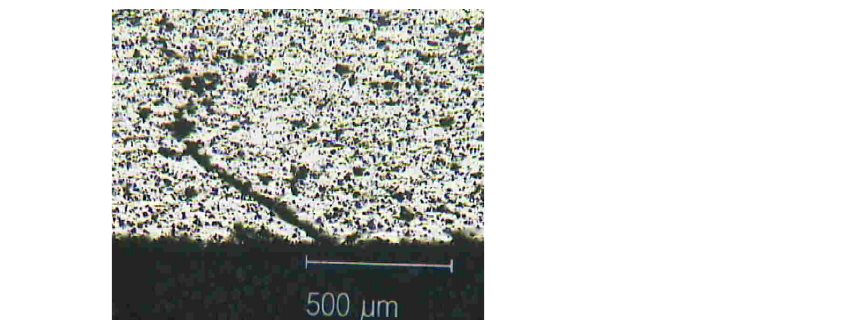
Figura 4: Difetto dovuto alla non completa penetrazione di saldatura sul lato opposto alla spalla dell’utensile nel giunto FSW sul composito W7A10A.